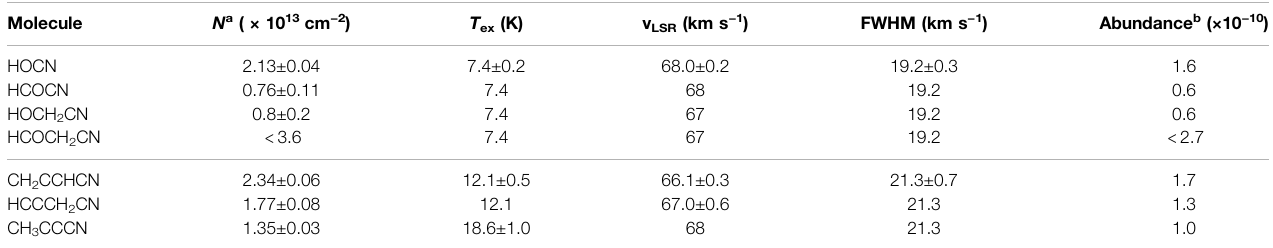
TABLE 4 | Derived physical parameters of the nitriles towards G+0.693 analysed in this work using MADCUBA, along with their associated uncertainties. The fi xed parameters used in the fi t are shown without associated uncertainties (see text).